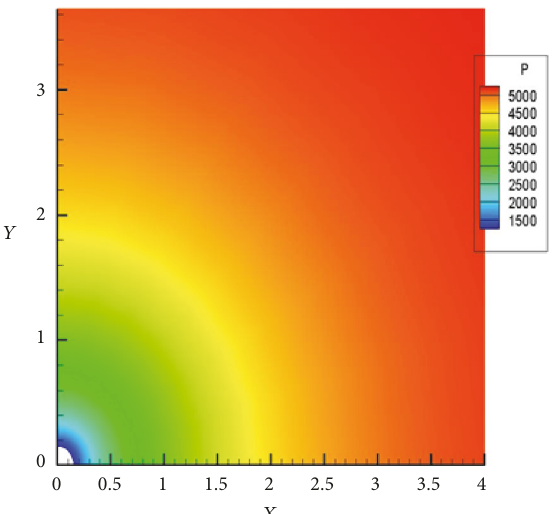
Figure 7: Pore pressure contour map after 1hr of fluid production (for near-wellbore region) with 𝜎 𝐻 = 5800 psi and 𝜎 ℎ = 5500 psi, 𝑃 𝑟 = 5500 psi, 𝑃 𝑤 = 1000 psi, 𝑘 𝑥 = 0.01 md, and 𝑘 𝑦 = 0.01 md.